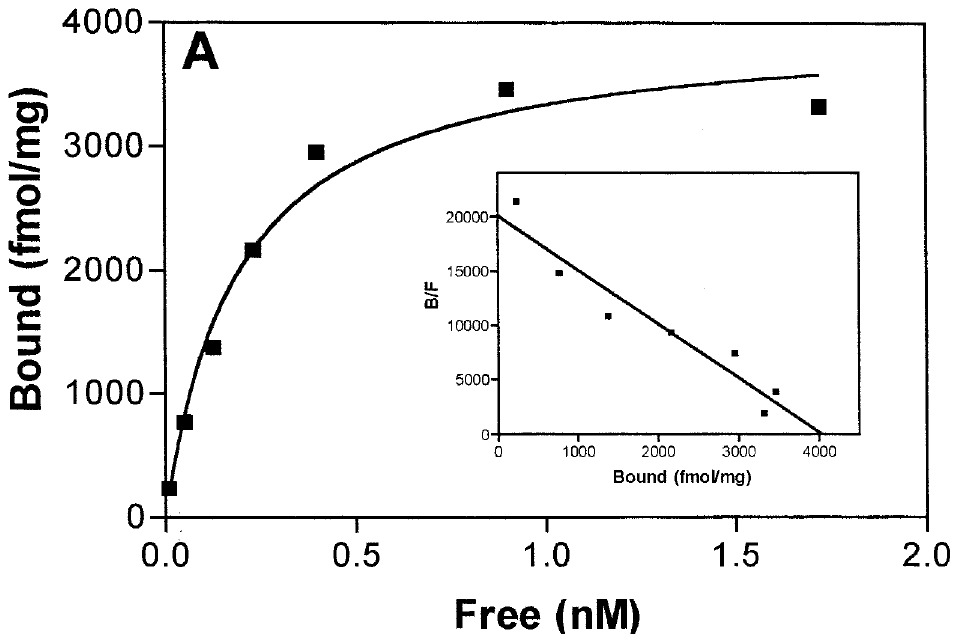
FIG. 2. Saturation analysis of [ 125 I]hIL-5 binding to Sf9 membranes expressing hIL-5r ab . Plasma membranes from Sf9 cells infected with baculovirus containing hIL-5r ab were incubated with 30pM–5nM [ 125 I]hIL-5 under standard binding conditions. Data were analyzed as discussed in Methods and linearized according to the method of Scatchard (inset). Data represent the mean of triplicate determinations from a typical experiment.